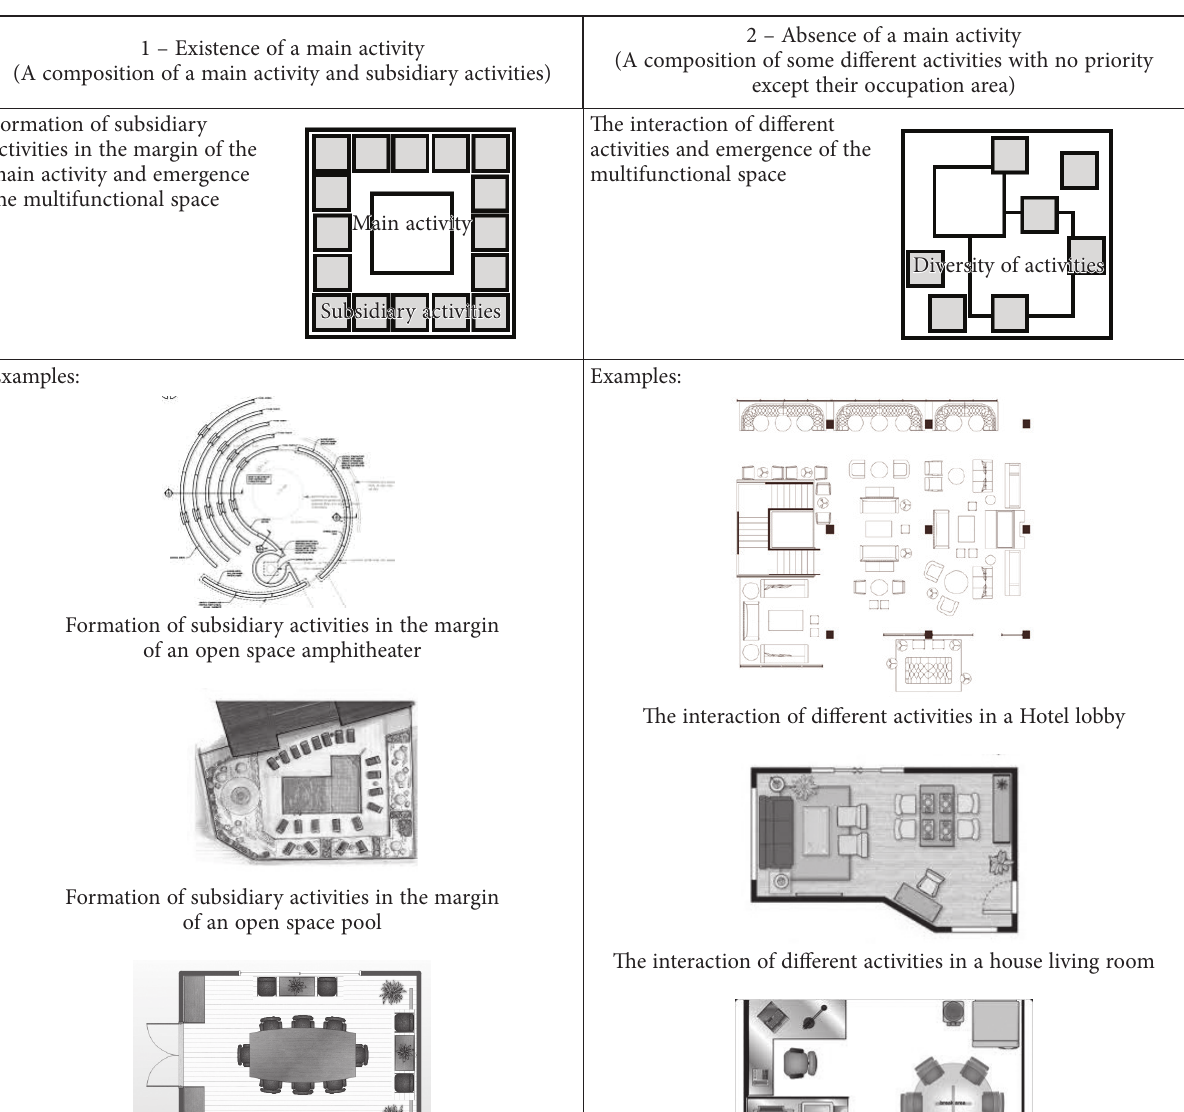
Table 4. Differences in the formation of multifunctional